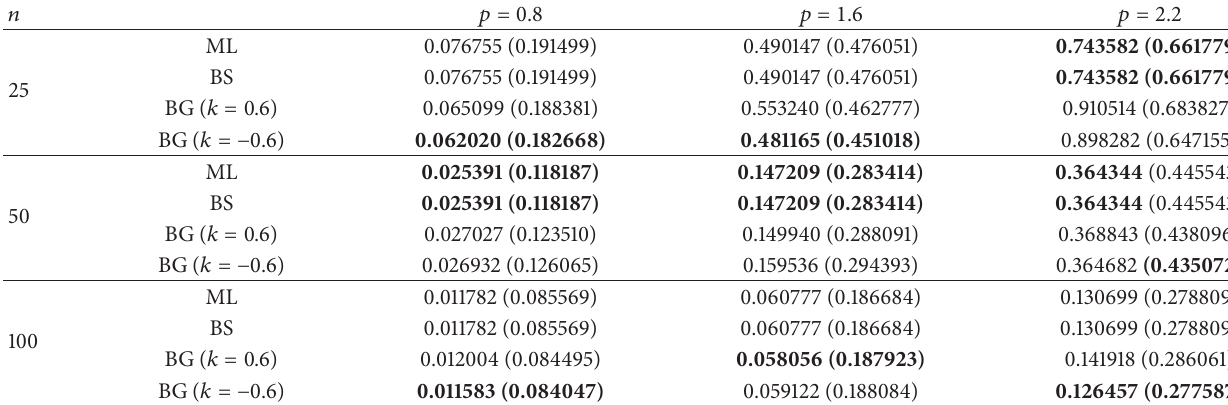
Table 4: Average mean squared errors and absolute biases of (̂𝑝)